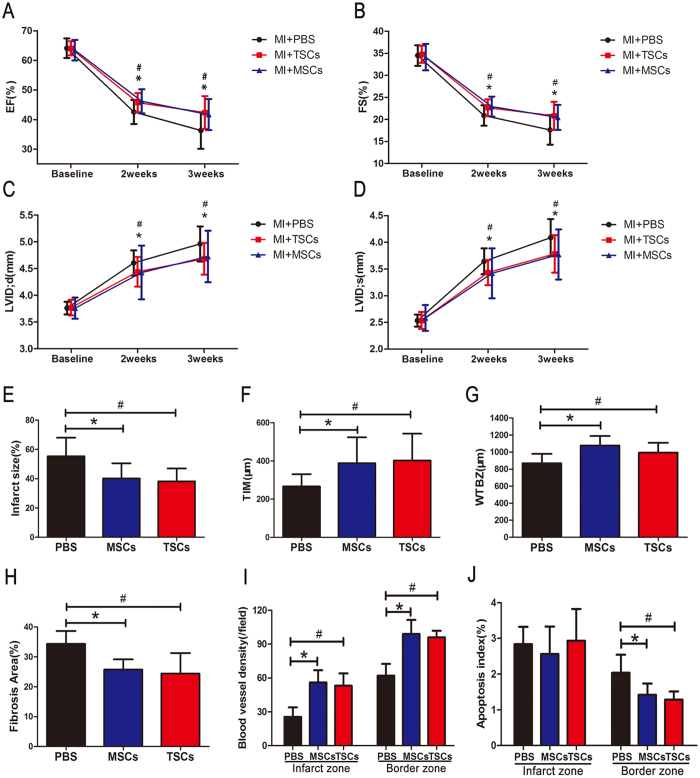
Cardiac function and remodeling after cell transplantation.(A–D) Sequential echocardiographical assessments of the infarcted mice at baseline, 2 weeks, and 3 weeks showed an increase in EF and FS, as well as, a decrease in LVIDd and LVIDs in TSCs- or MSCs- treated animals as compared to the PBS group. (E) Infarct size expressed as a percentage of left ventricular area in the cell therapy groups was significantly smaller than the PBS treated group. (F,G) TIM and WTBZ in cell-treated hearts were substantially higher than the PBS-treated hearts. (H) Quantification of interstitial fibrosis in the border zone of the three groups revealed that the cell therapy decreased the fibrosis of hearts after MI. (I) Quantification of CD31+ capillaries suggested that the density of vessels in the cell-treated groups were significantly higher than in the PBS-treated group both in the infarct and border zones. (J) Quantification of Tunel+ cells showed that the apoptotic cells in the cell-engrafted groups were significantly lower than in the PBS-treated group at the border zone, but no difference was seen in the infarct zone among the three groups. n = 8 for each group. *P < 0.05, MSCs-treated group vs. PBS-treated group; #P < 0.05, TSCs-treated group vs. PBS-treated group. Data are depicted as mean ± SD.